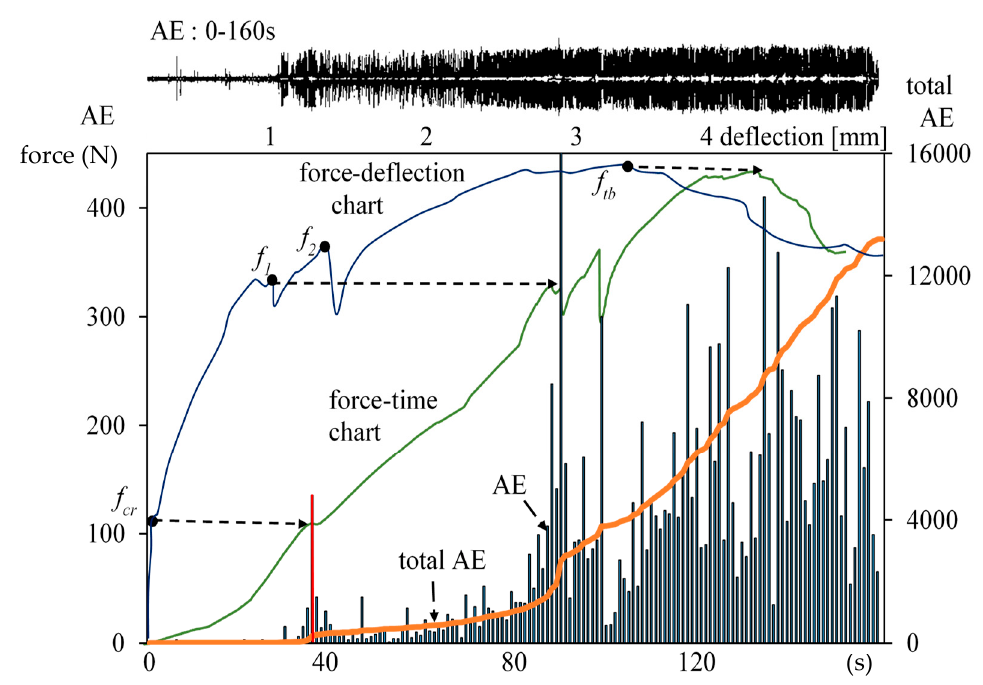
Figure 3. Results of tests on the composite in the range of 0–160 s: force-deflection, force-time curve, total acoustic emission AE, events, and AE recording.